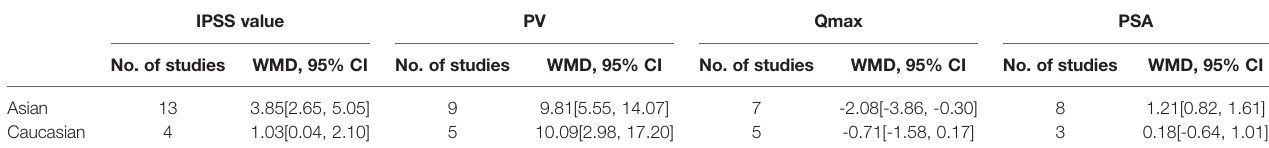
TABLE 2 | The results of different outcomes according to the